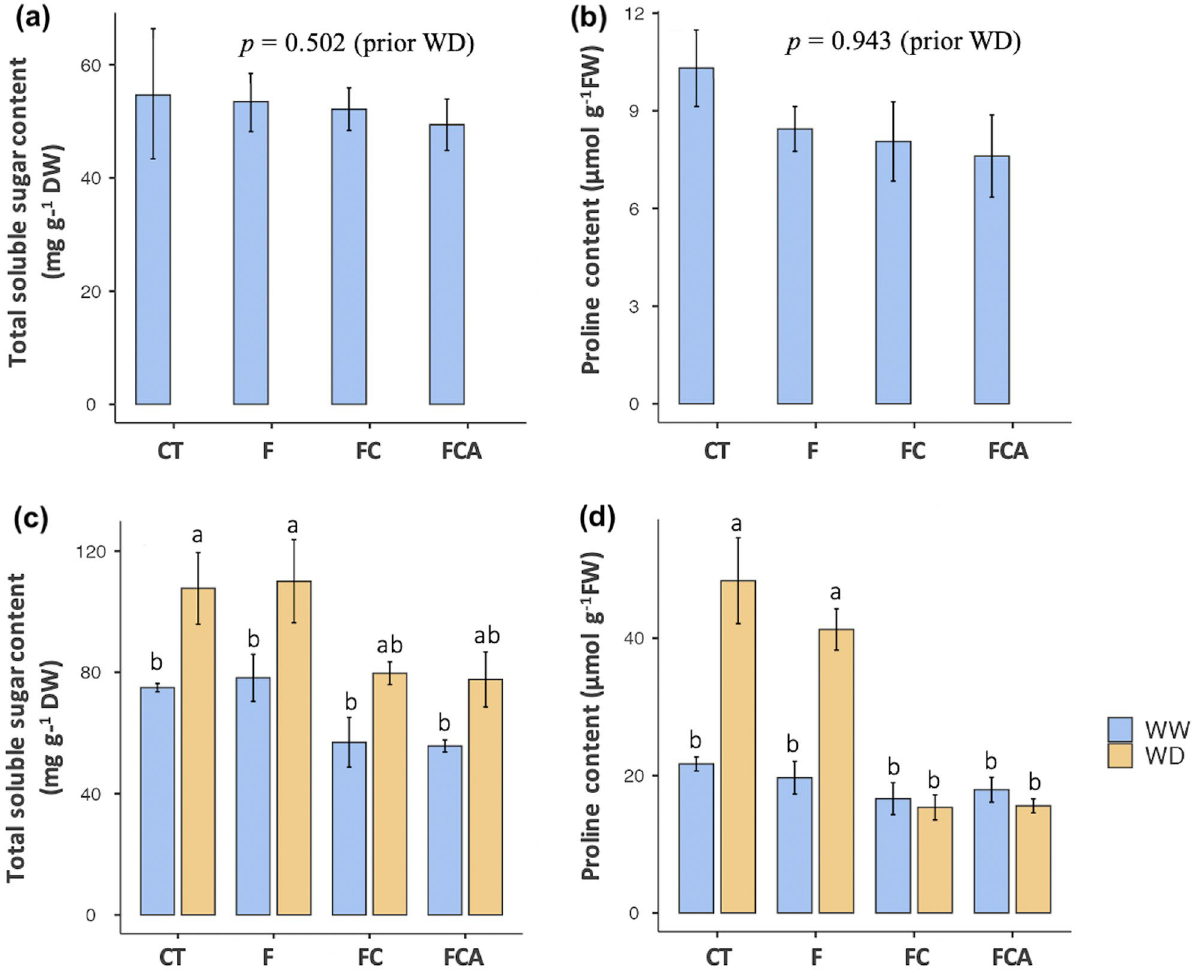
Figure 1. Total sugar soluble content and proline content of rice cv. Leum Pua inoculated with or without AMFs ( Funneliformis mosseae ; F, with Claroideoglomus etunicatum ; C, and Acaulospora fovaeta ; A, in F, FC, FCA, and uninoculated control, CT) under prior water deficit on day 0 ( a and b ) and day 21 of well-watered and water deficit conditions ( c and d ). Statistical data access with a minimum of n = 4 and mean ± standard deviation. Different letters along plots represent significant difference at p =